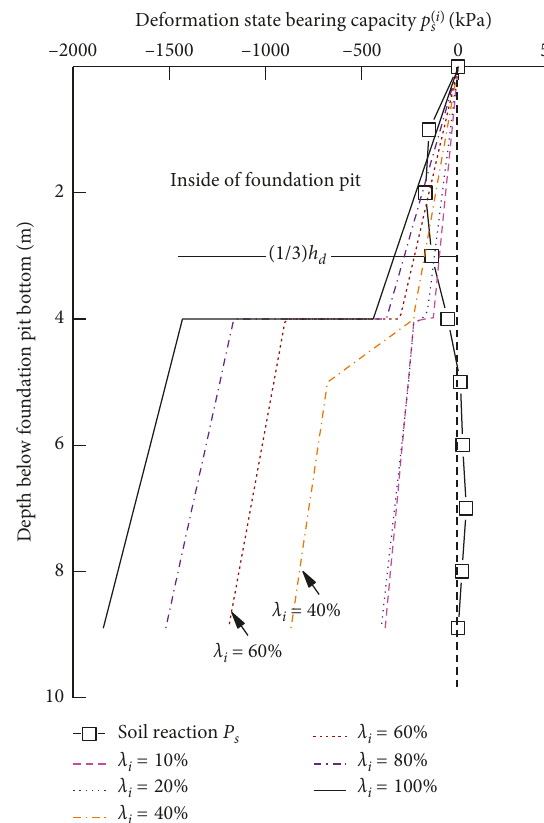
Figure 4: Curve of the relationship between the deformation state bearing capacity p ( i ) s and the soil reaction p s . Table 5: Internal friction angle φ of the soil.